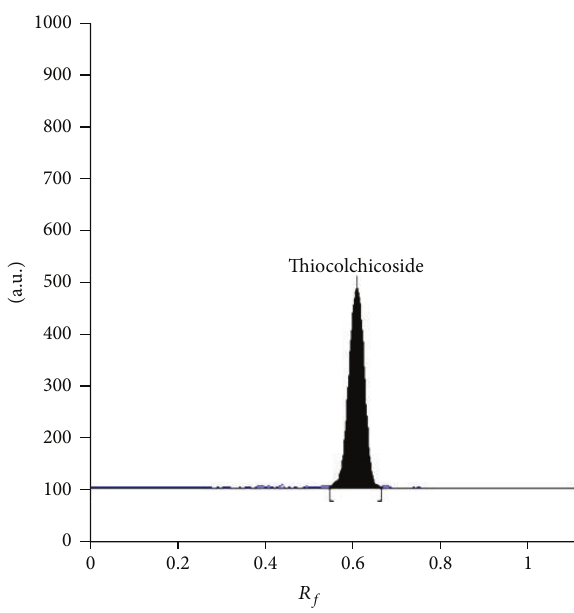
Figure 2: Chromatogram of thiocolchicoside standard with ( 𝑅 𝑓 0.60 ± 0.02) at 377 nm in methanol: water (70:30 v/v) as mobile